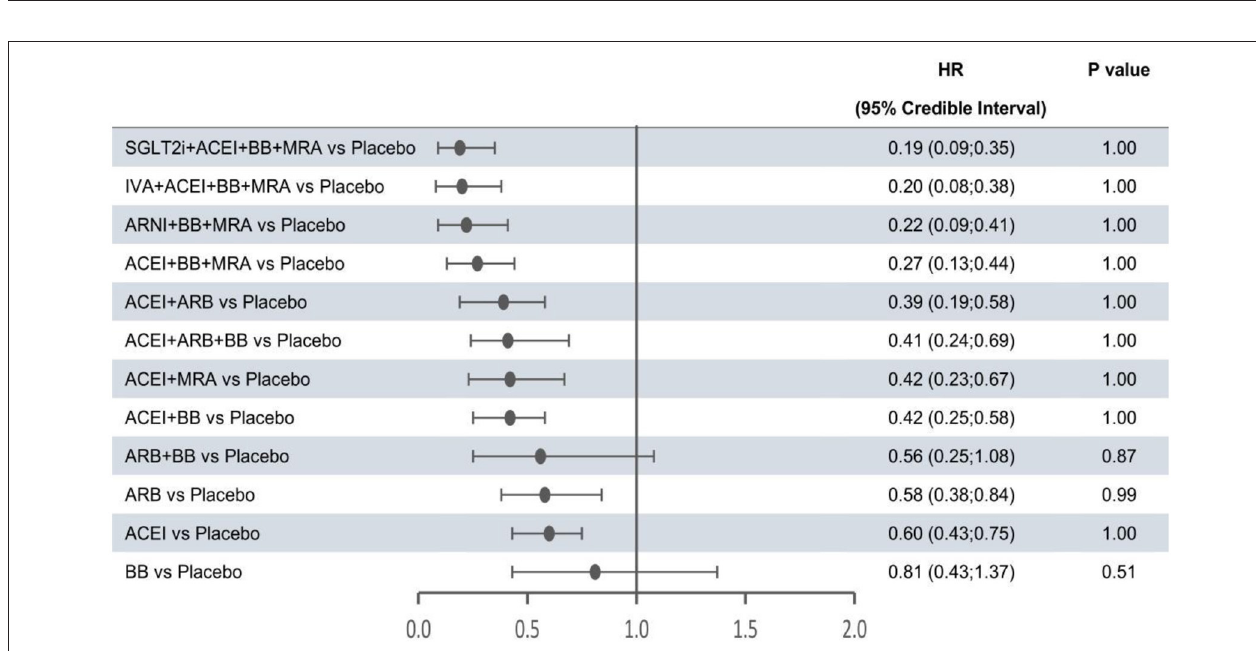
FIGURE 4 | Efficacy of interventions vs. placebo in hospital admission for heart failure. Hospital admission for heart failure was reported as hazard ratios (HRs) and 95% credible intervals for treatment vs. placebo. P -values were calculated based on the 95% credible intervals of hazard ratios and indicated the probability that the treatment was better than placebo. ACEI, angiotensin-converting enzyme inhibitor; ARB, angiotensin receptor blocker; ARNI, angiotensin receptor-neprilysin inhibitor; BB, beta-blocker; IVA, ivabradine; MRA, mineralocorticoid receptor antagonist; SGLT2i, sodium-glucose cotransporter 2 inhibitor.